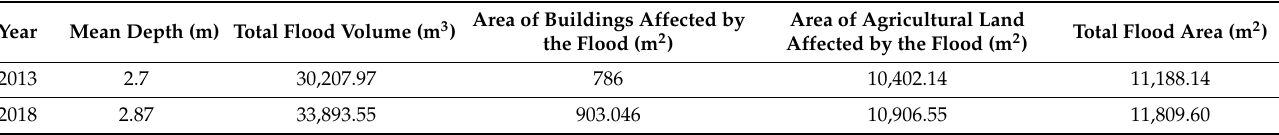
Table 11. Flood water characteristics of the river during the study period.